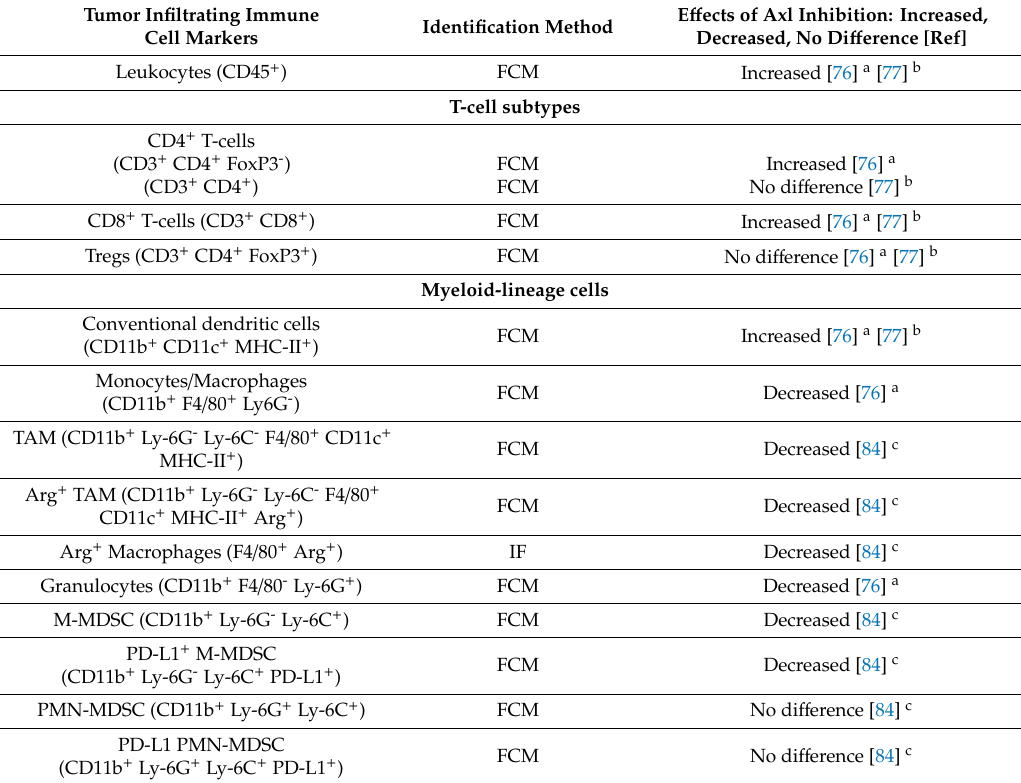
Table 2. E ff ects of Axl Inhibition on Tumor Infiltrating Immune Cells. Tumor Infiltrating Immune Identification Cell Markers